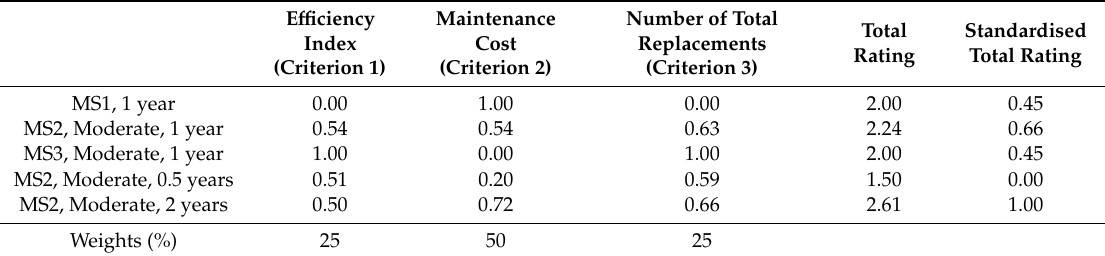
Table 11. Scenario 3: the higher weight of the maintenance costs.